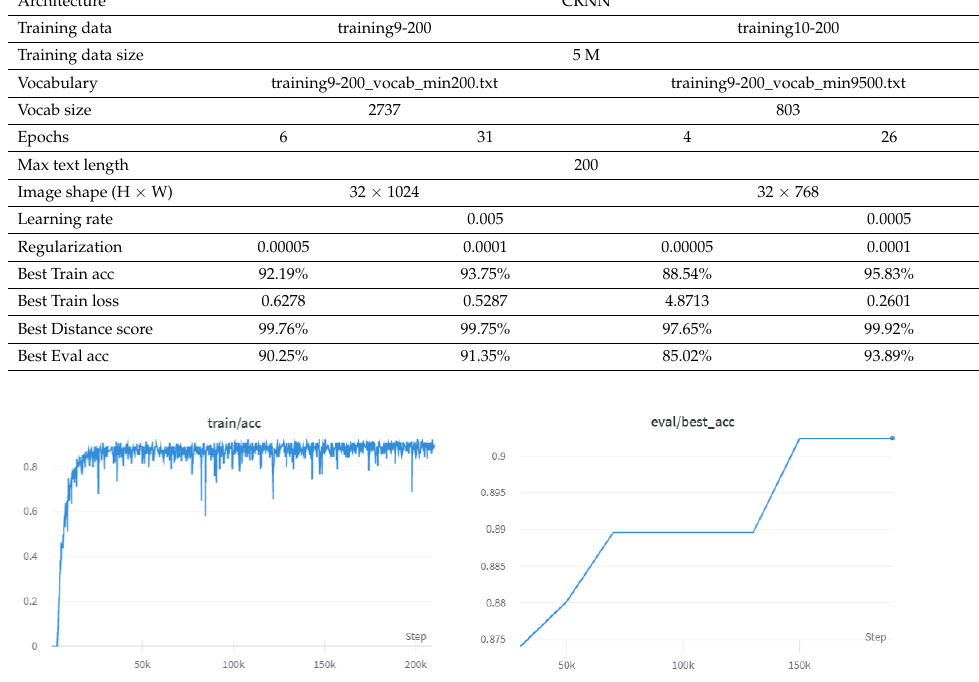
Figure 14. Best training and evaluation accuracy in ‘Experiment